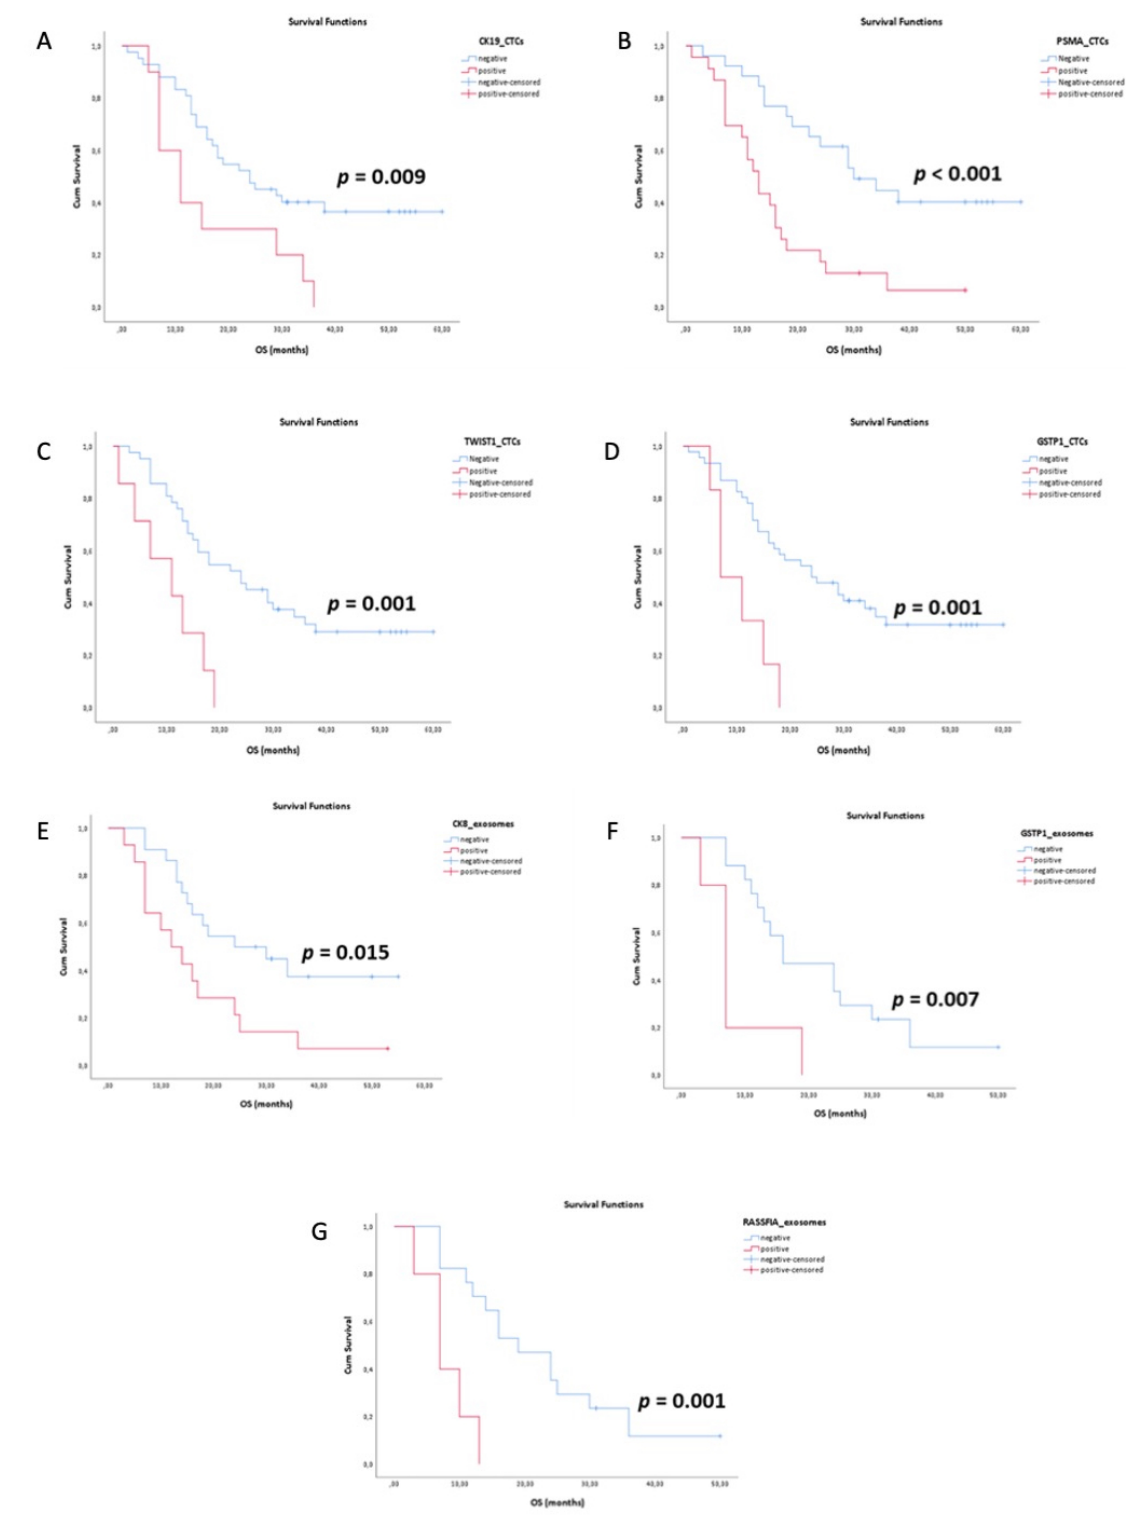
Figure 3. Kaplan–Meier estimates of overall survival (OS) in CTCs: ( A ) CK-19, ( B ) PSMA, ( C ) TWIST1, ( D ) GSTP1 and in exosomes ( E ) CK-8, ( F ) GSTP1, ( G ) RASSF1A. In CTCs, univariate analysis showed a significantly higher risk of death in the group of patients positive for CK-19 (HR: 2.566, p = 0.013), TWIST1 (HR: 3.818, p = 0.003),